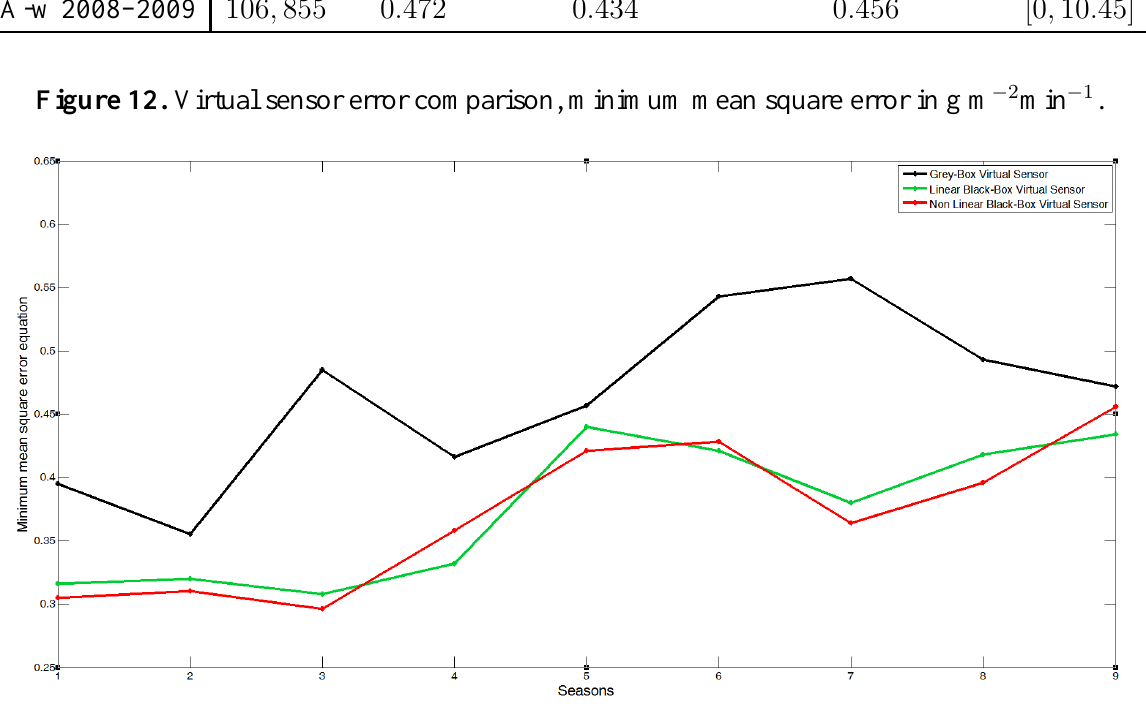
Table 5. Grey-virtual sensor error calculation in g m − 2 min − 1